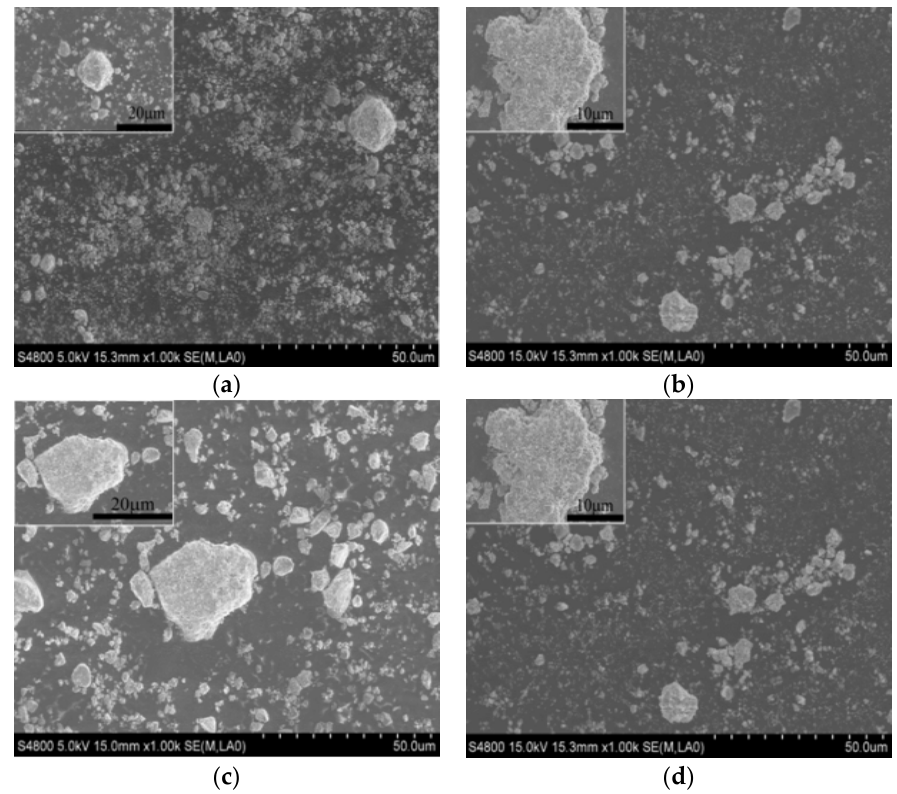
Figure 1. Morphology of the powder after the mechanical alloying (MA): ( a ) 20TiB 2 ‐ NiCr; ( b ) 40%TiB 2 ‐ NiCr; ( c ) 60TiB 2 ‐ NiCr; and ( d ) Cr 3 C 2 ‐ 25NiCr.